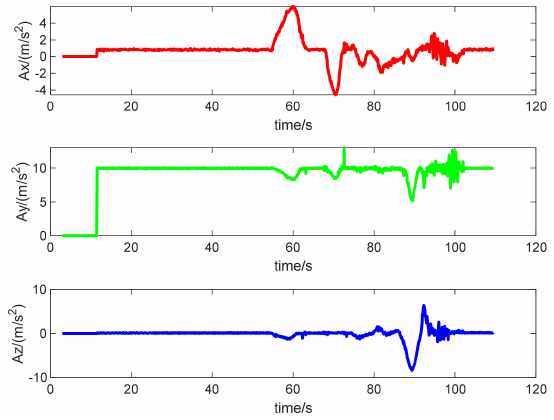
Figure 16. Measured triaxial acceleration data.